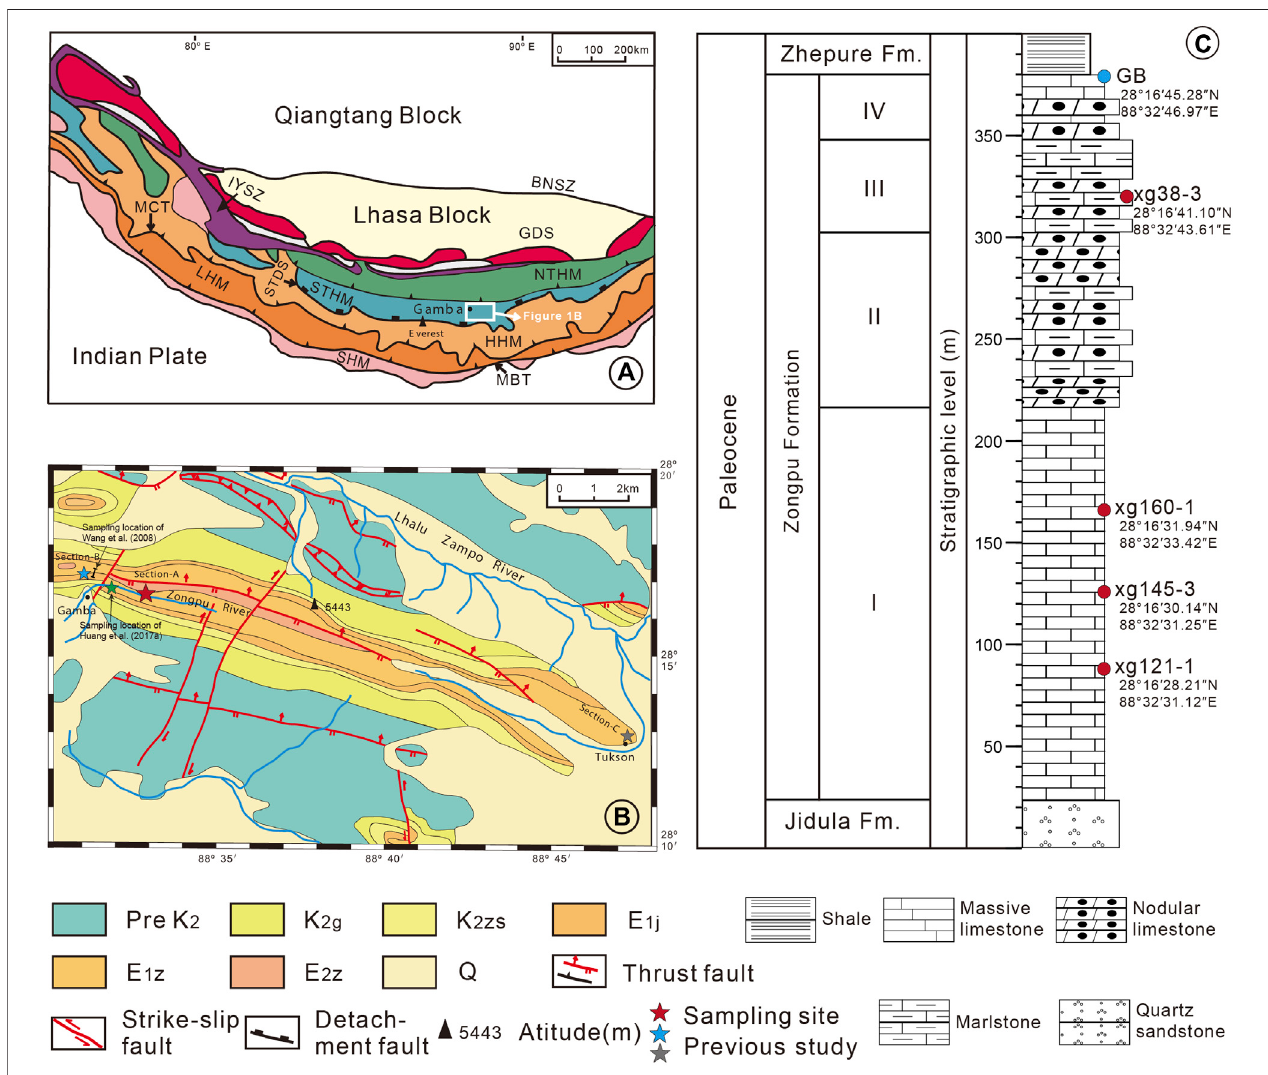
FIGURE1|(A) SchematicstructuralmapoftheIndia-Asiacollisionzone. (B) GeologicmapoftheGambaareawiththepaleomagneticsamplinglocationsofYietal. (2011) (section A – C) and Huang et al. (2017a) (green star). The sampling location of strontium isotopesstudy (Wang et al., 2008) was also marked. (C) Lithostratigraphy of section A of Yi et al. (2011). Red and blue dots indicate the sampling levels for samples collected for thin sections observation and magnetic extraction, respectively.